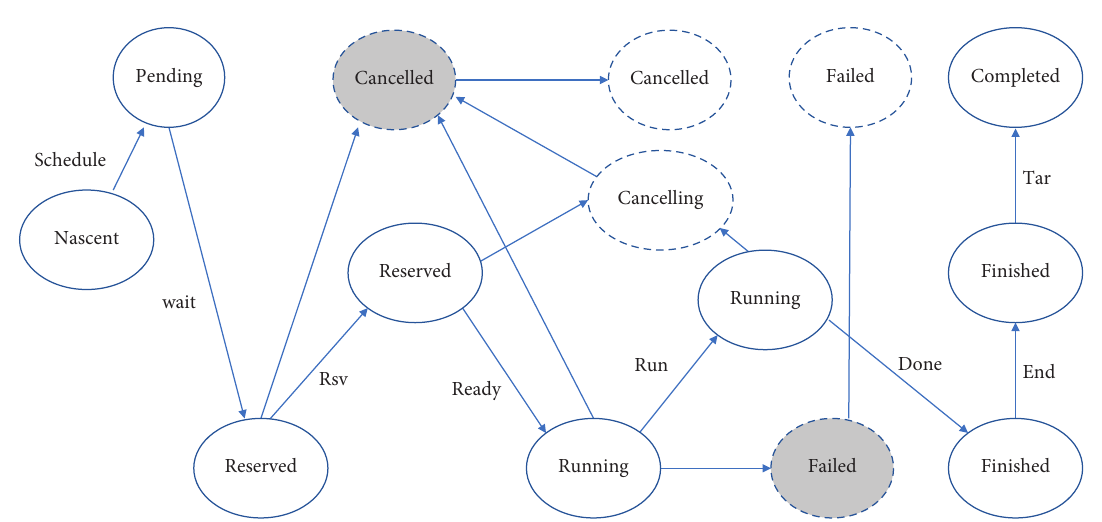
Figure 7: Software state machine.